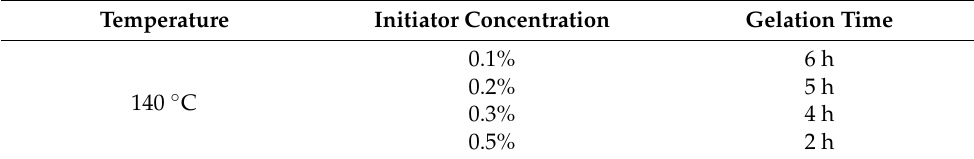
Table 2. The gelation time of gel under different initiator